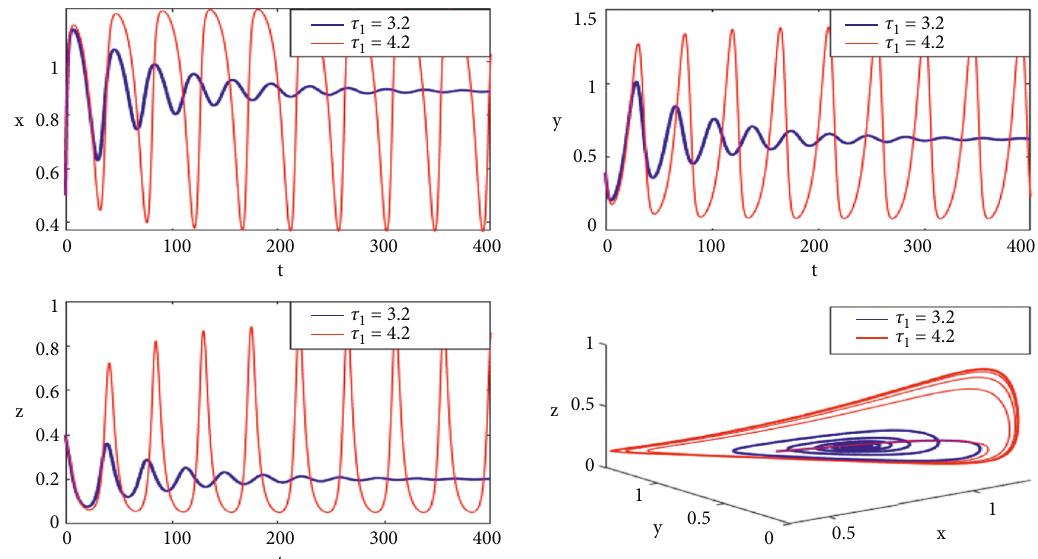
Figure 5: Case 3: the trajectories and phase diagrams of system (92) over time at τ